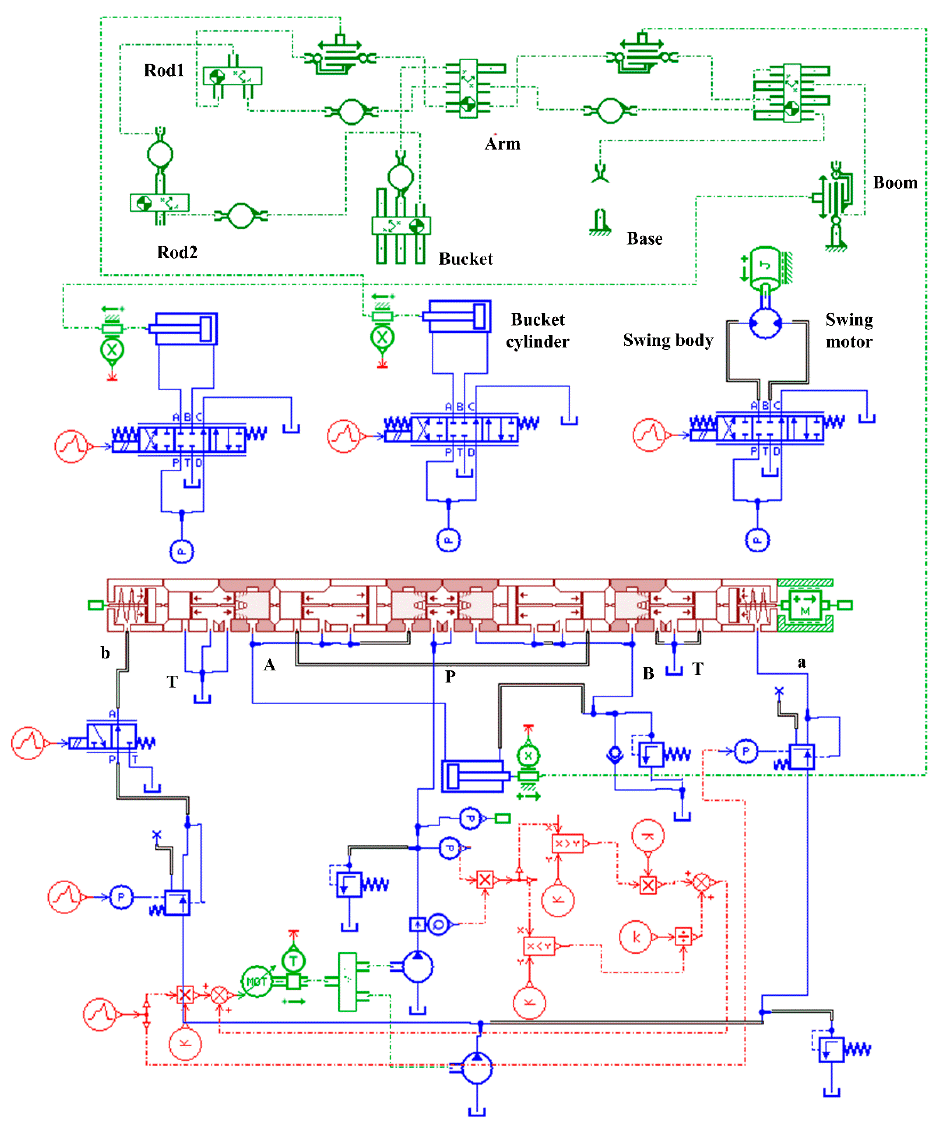
Figure 4. Simulation model of PFS based on variable speed control.